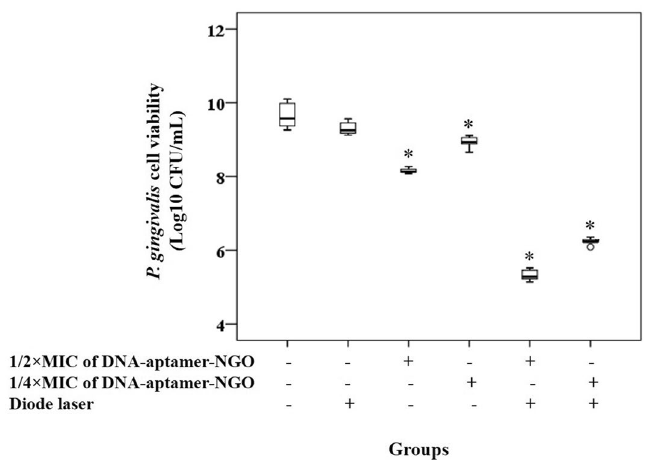
Figure 11. The antimicrobial effect of different treatment groups against P. gingivalis . Cell viability of P. gingivalis following treatment with 1/2 × and 1/4 × MIC of DNA-aptamer-NGO, aPDT (DNA-aptamer-NGO at 1/2 × and 1/4 × MIC plus diode laser), and diode laser were quantified by colony counting. Significant differences according to the control, * P < 0.05.